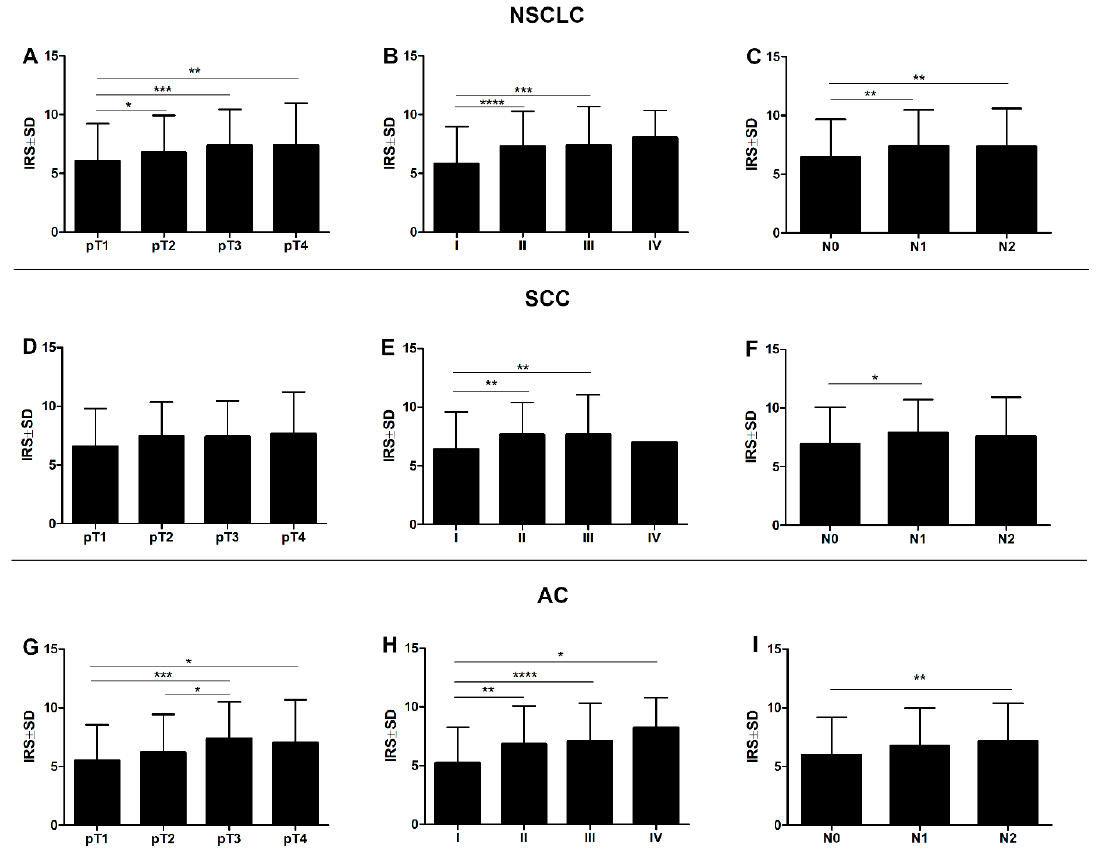
Figure 5. Expression level of periostin (POSTN) with regard to the clinicopathological factors of patients. Comparison of immunohistochemical periostin (POSTN) expression in the stromal cells (CAFs) of the non-small cell lung carcinoma (NSCLC), squamous cell cancer (SCC), and adenocarcinoma (AC) subtypes, ( A , D , G , respectively) according to the tumour size (* p < 0.05, ** p < 0.005, *** p < 0.001), ( B , E , H ) clinical cancer stage (* p < 0.05, ** p < 0.005, *** p < 0.001, **** p < 0.0001), and ( C , F , I ) lymph node status (* p < 0.05, ** p < 0.005); Mann–Whitney U test.